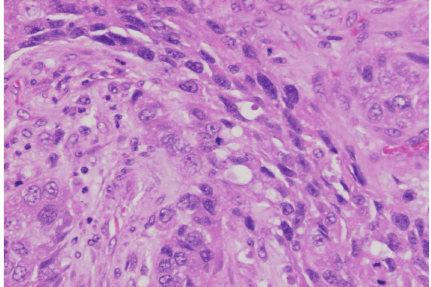
Figure 1: Tumour cells with unusual shapes and variable sizes includingmultinucleatedgiantcells.Notethepleomorphicvesicular nuclei and abundant pale stained cytoplasm (haematoxylin and eosin × 200).